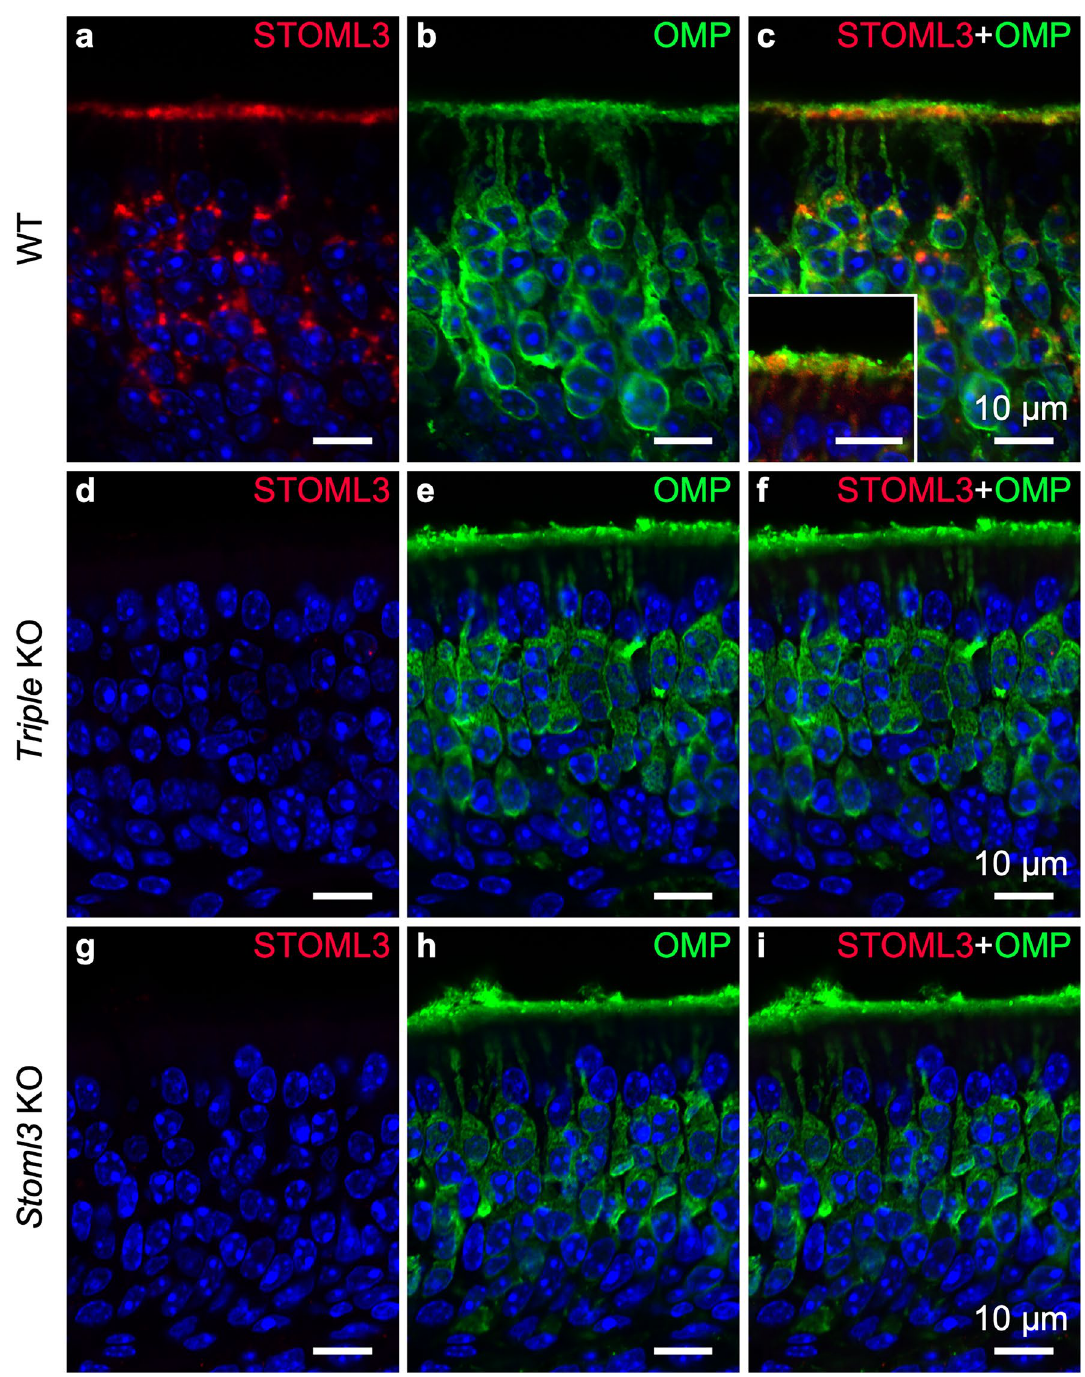
Figure 8. STOML3 expression in the olfactory epithelium. Single optical plane confocal micrographs of coronal sections of the OE of WT ( a – c ), Triple KO ( d–f ), and Stoml3 KO ( g-i ) mice, double-stained with anti-STOML3 (red) and anti-OMP (green) antibodies. In WT mice, STOML3 predominantly localizes in a continuous thin layer located along the basal portion of the cilia and knobs of OSNs. The inset in c shows the localization of STOML3 in the knob/basal part of the cilia. Resembling STOM expression, STOML3 also is detected in several puncta in the cell body of most OSNs. STOML3 signal is not visible in triple KO and Stoml3 KO mice, confirming the specificity of the signal observed in WT. Nuclei were stained with DAPI (blue). Inset scale bar 10